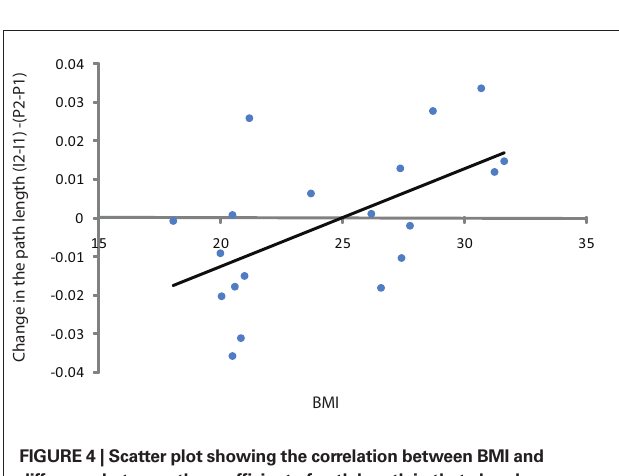
FiGurE 4 | Scatter plot showing the correlation between BMi and difference between the coefficient of path length in theta band (difference between basal measurement and after administration of the insulin corrected for the placebo measurement) for all